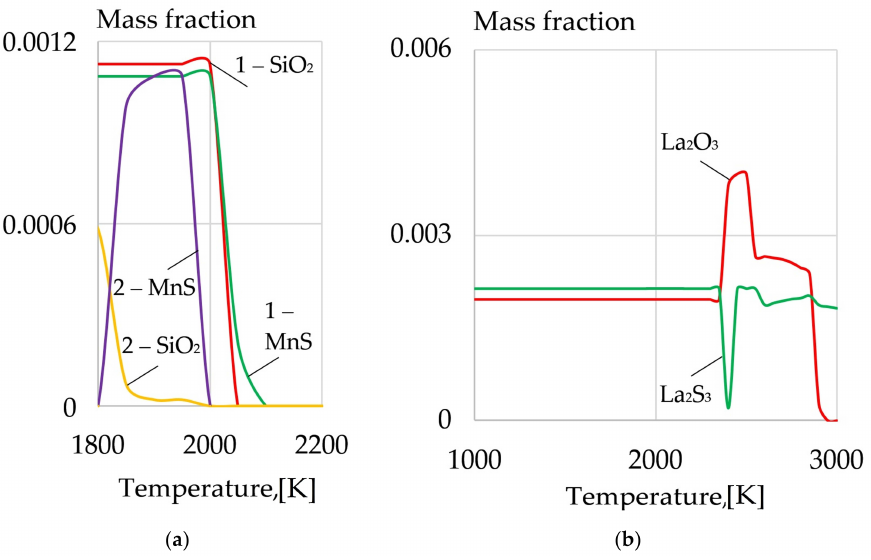
Figure 11. ( a ) The content of SiO 2 and MnS in 09G2S steel: (1) without REMs, (2) with addition of 1% mixture of LaF 3 and LaB 6 ; ( b ) the content of La 2 O 3 and La 2 S 3 in 09G2S